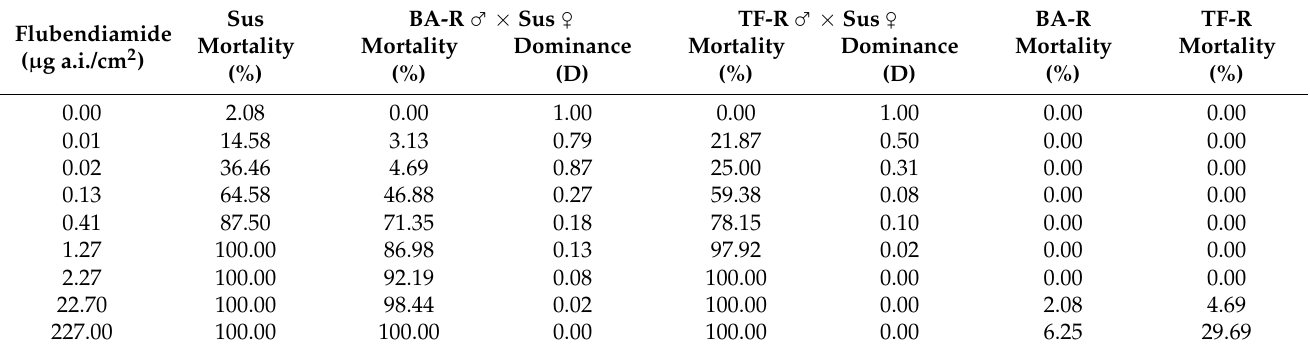
Table 2. Degree of dominance (D) according to Bourget [56] in reciprocal crossings of different strains of Spodoptera frugiperda as a function of increasing flubendiamide concentration.